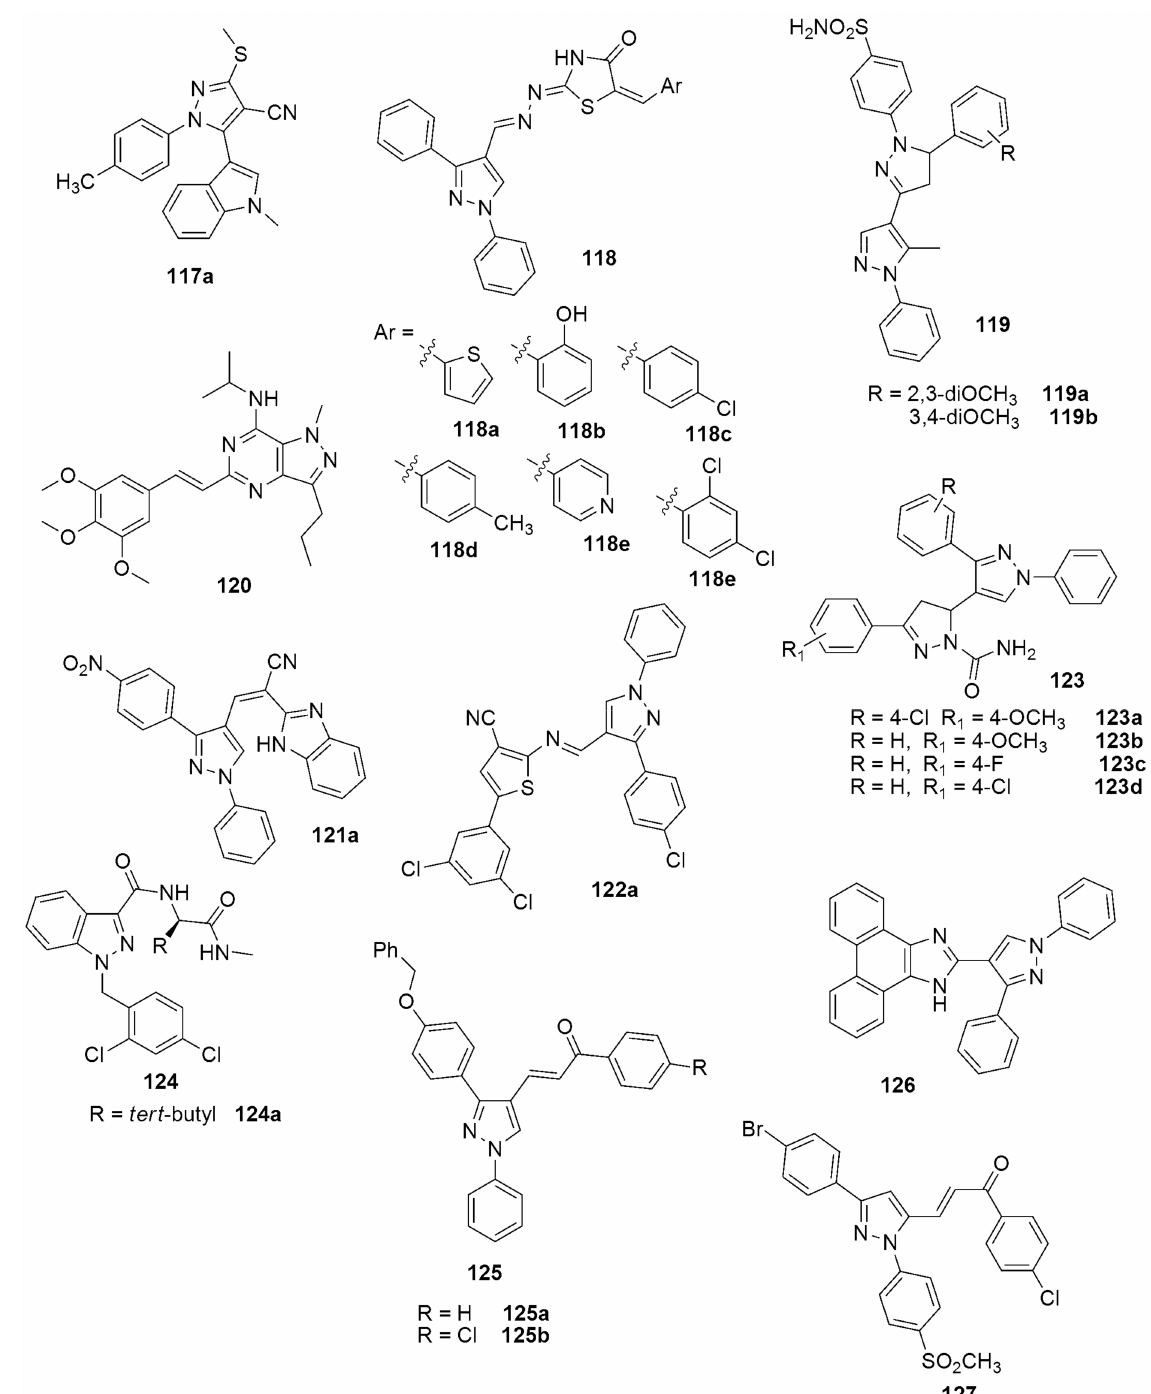
Figure 3. Structures of pyrazole derivatives with anti-inflammatory